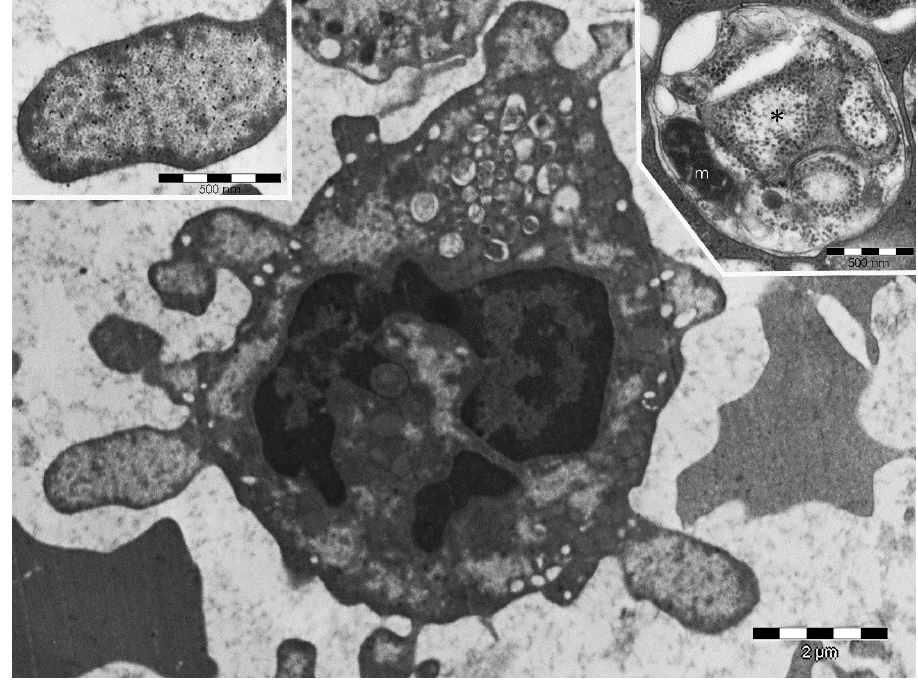
Figure 5. PaCS-filled blebs, ectosomes, and autophagic vesicles in myeloid-leukemia cells. Human bone-marrow biopsy showing a myeloid-leukemia cell with several cytoplasmic and bleb-filling PaCSs, one of which is enlarged in the top-left inset to show typical barrel-like particles and FK1 antibody pUbPs reactivity. In addition, note, in the bottom center of the cell, the detaching PaCS-bearing blebs forming extracellular ectosomes and, in the top-mid part of the cell, many autophagic vesicles. In the top-right inset, an autophagic vesicle from another myeloid-leukemia cell shows a distinctive double membrane enveloping a remnant of a small PaCS (asterisk), some ribosomes (free or attached to ER cisternae), and a mitochondrion (m).